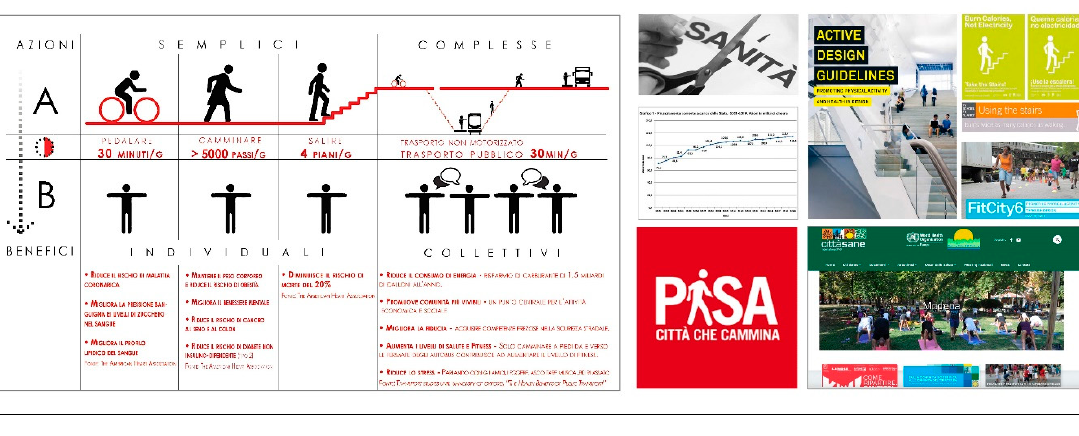
Lifestyles and cities of the future 3